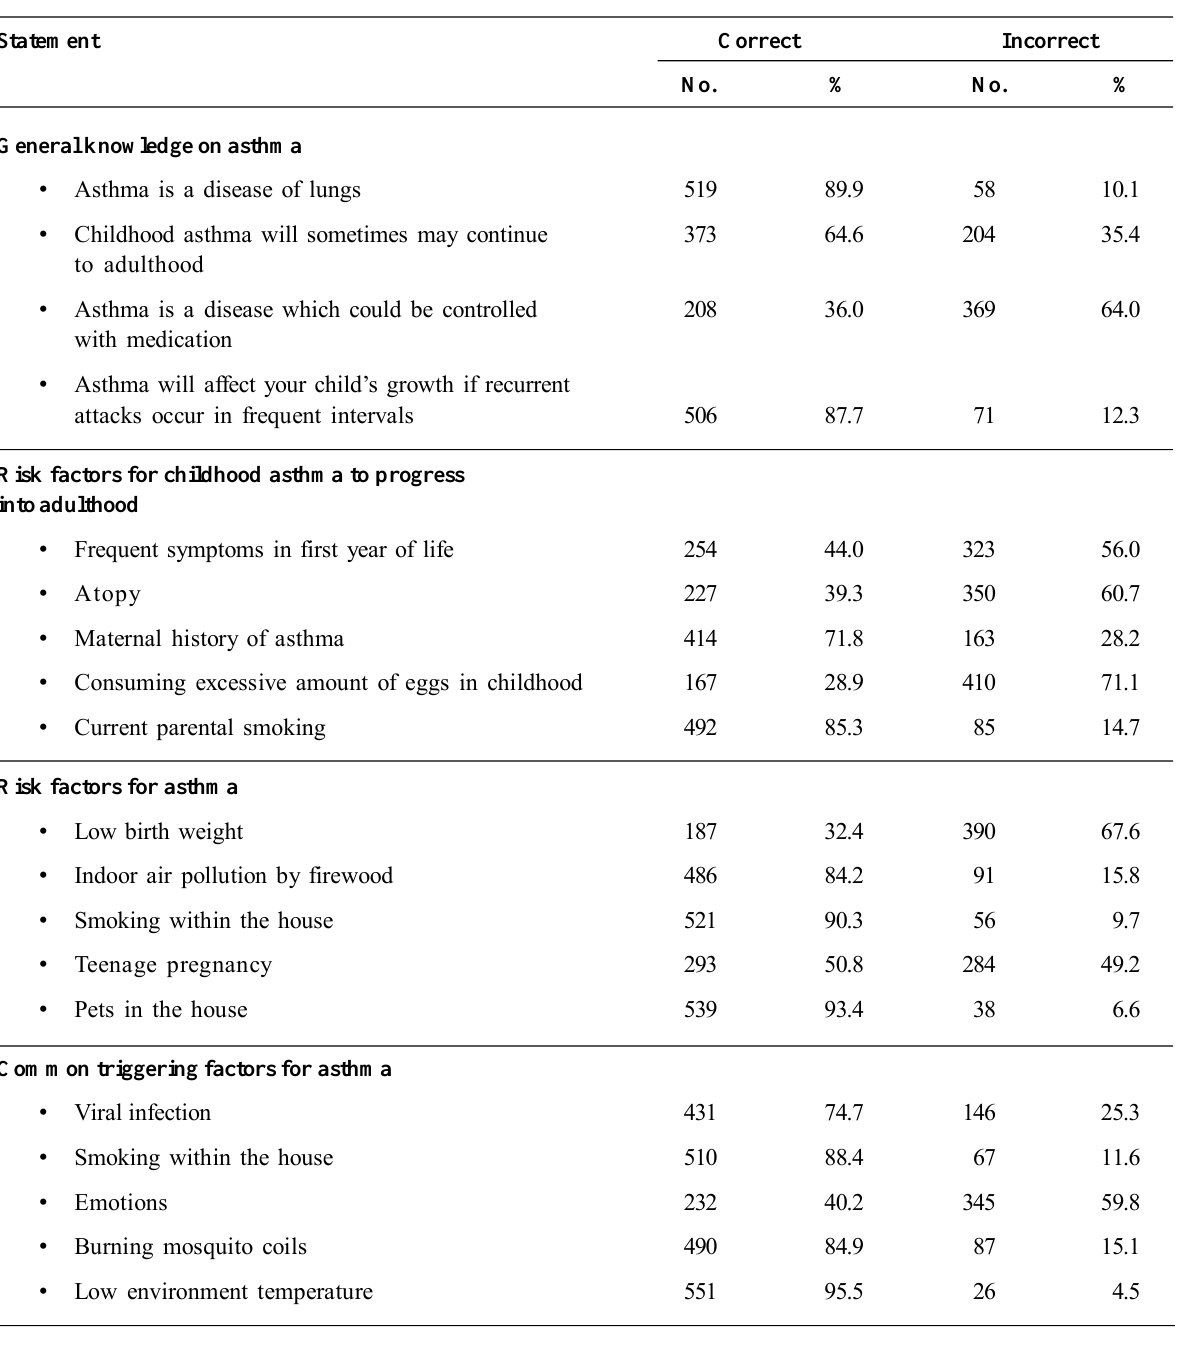
Table 1. Distribution of the caregivers’ knowledge on asthma and risk factors (N = 577)